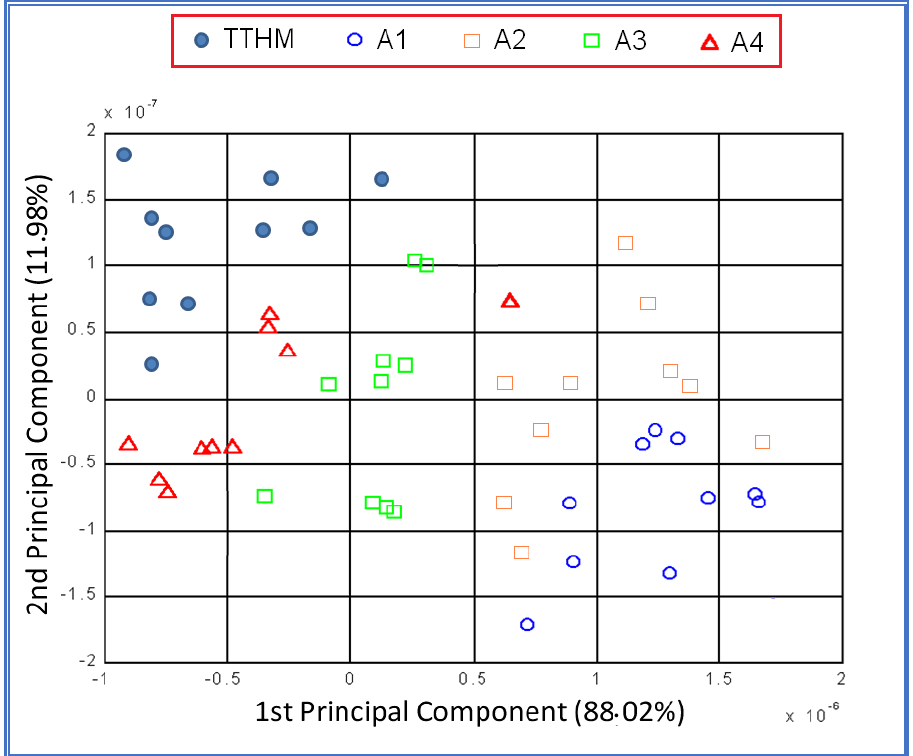
Fig. 8. PCA graph for the TTHM samples and samples A1, A2, A3 and A4, collected at the São João ranch, for the set composed of 10